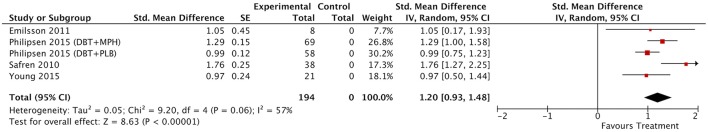
Forest plot for within-subject CGI outcome.